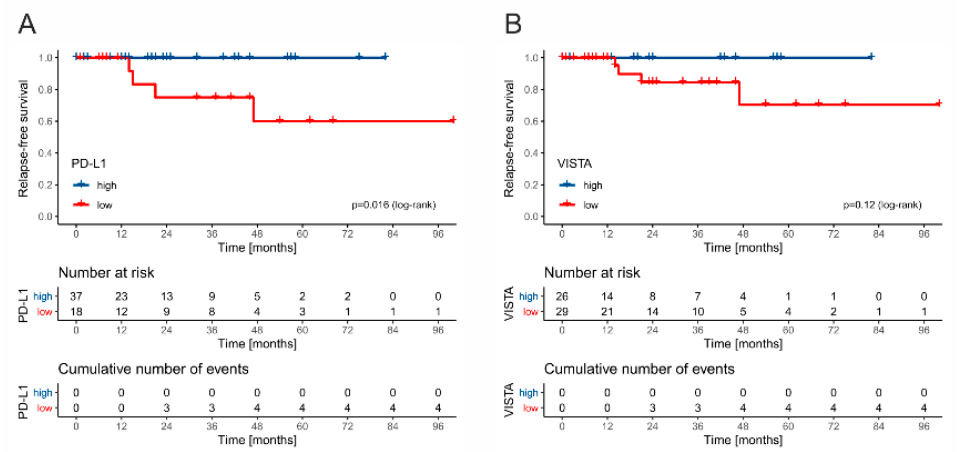
Figure 7. The Kaplan–Meier curves for relapse-free survival in stage I patients treated with adjuvant chemotherapy stratified by PD-L1 ( A ) and VISTA ( B ).